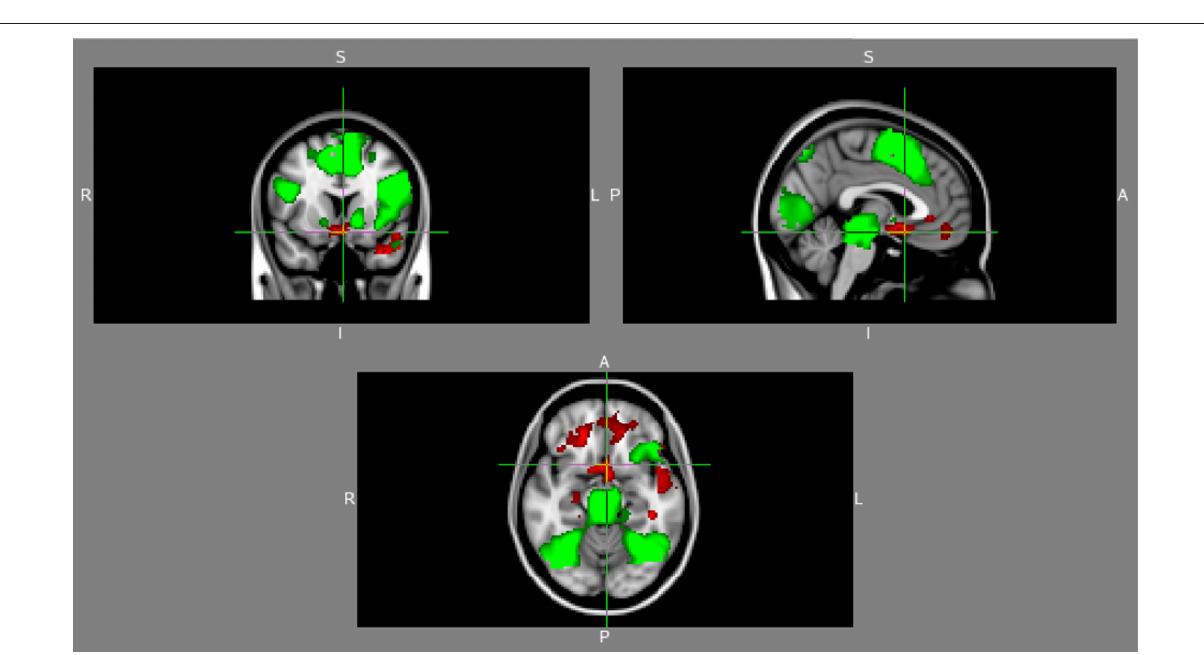
FIguRe 4 | Baseline (green) and added activations with oxytocin compared to placebo (red) in healthy matched controls during